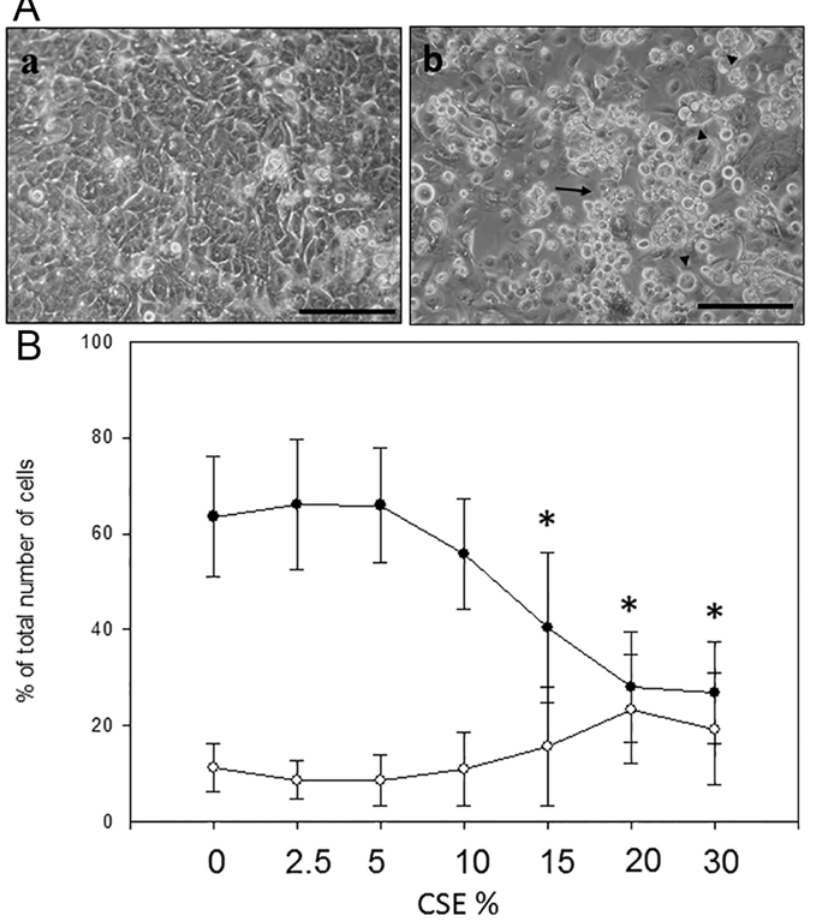
Fig 1. Effect of Increasing Doses of CSE on PBEC cultures. Panel A: PBEC were serum starved for 24h before being treated with serum free medium (a) or 20% CSE (b) for a further 24h. Arrows indicate condensed apoptotic cells; arrowheads swollen necrotic cells; bar = 100 μ m. Panel B: PBEC obtained from 4 non-asthmatic and 4 asthmatic volunteers were treated with increasing doses of CSE for 24h. Viability and EA were assessed with AxV staining. The single curve points represent median ± SD in all 8 subjects for both viability ( ● ) and early apoptosis ( (cid:1) ). * = (p < 0.05) according to Wilcoxon Signed Rank test comparing CSE treatment with untreated